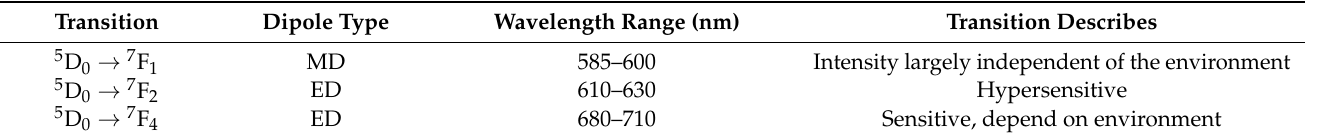
Table 3. The selected radiative transitions of Eu 3+ ions.